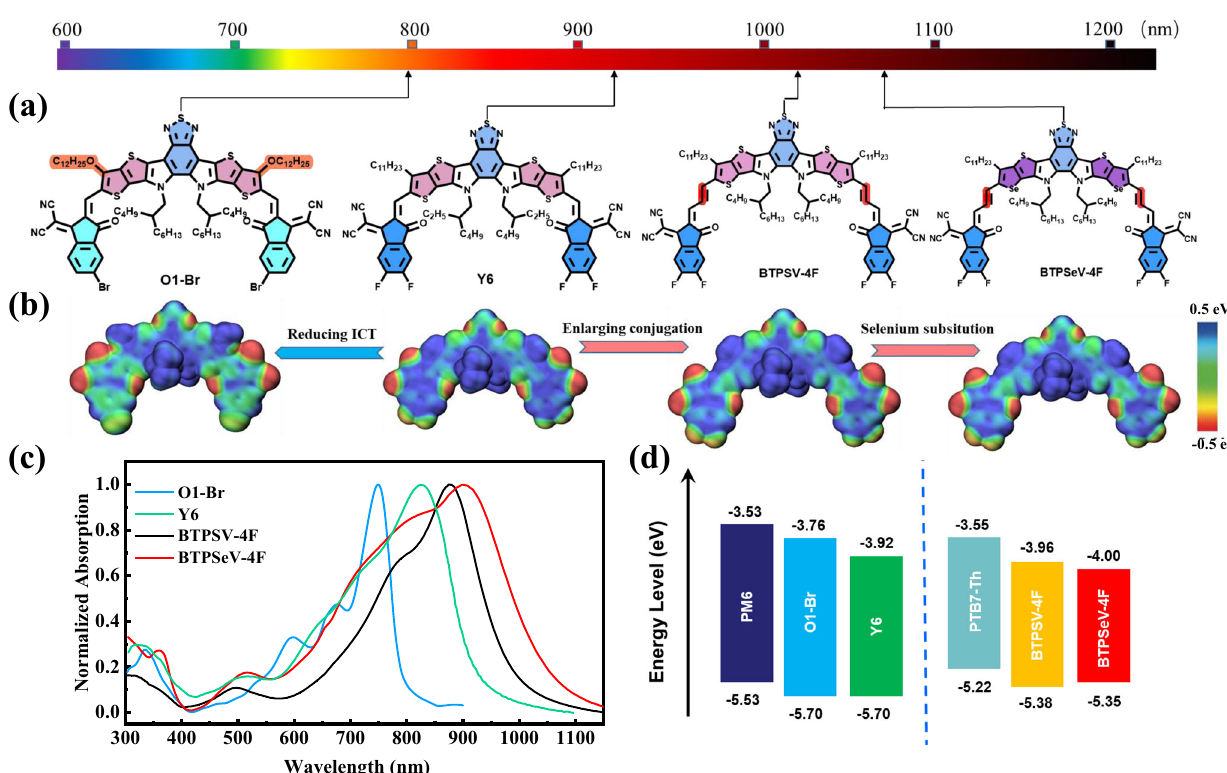
Fig. 1 | Materials design and characterization. a Molecular structures of the acceptorswitharrowsindicatingabsorptionedgewavelengthoftheacceptor fi lms. b ESP distributions for the simpli fi ed structures of O1-Br, Y6, BTPSV-4F, and